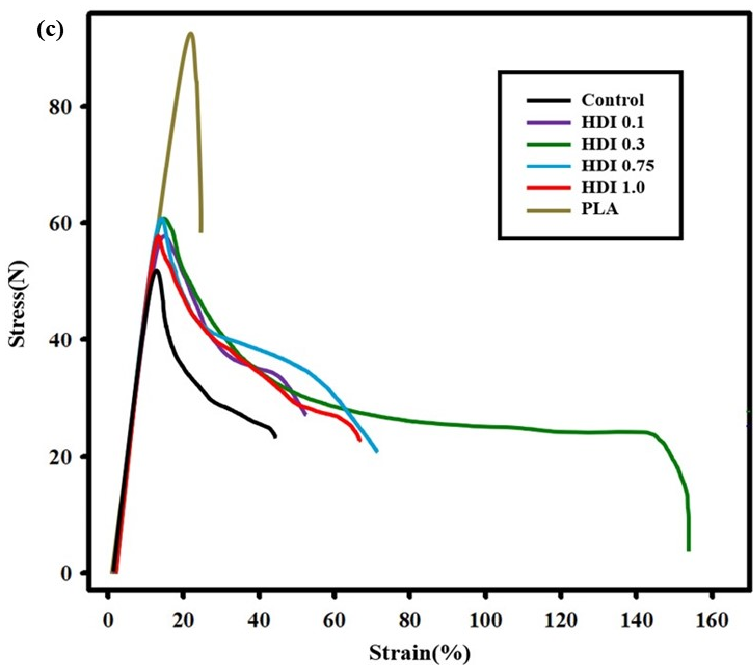
Figure 4. Tensile strength ( a ), elongation ( b ) characteristics and stress–strain curves ( c ) of neat PLA and blend specimens prepared with various HDI contents.